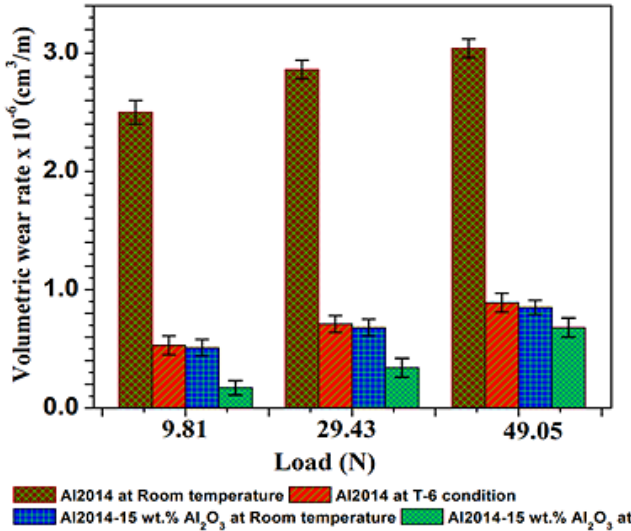
Figure 8. Comparison of the impact of the applied loads on the volumetric wear rate of Al2014 and Al2014-15 wt.% Al 2 O 3 as-cast, T6 condition, and error bar represents standard deviation. Table 4. Volumetric wear rate values of before and after heat-treated Al2014 alloy and its Al2014-15 wt.% Al 2 O 3 composite, with variable loads at constant speed and sliding distances. Variable Load (N)Compositions